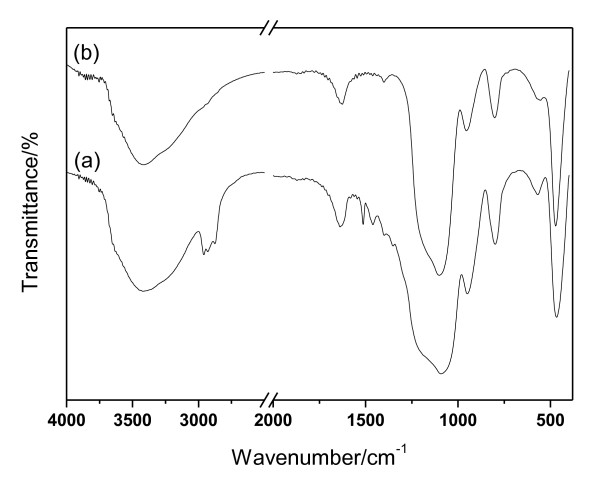
FTIR spectra of the as-prepared sample (a) and Co-SiO2 (b).